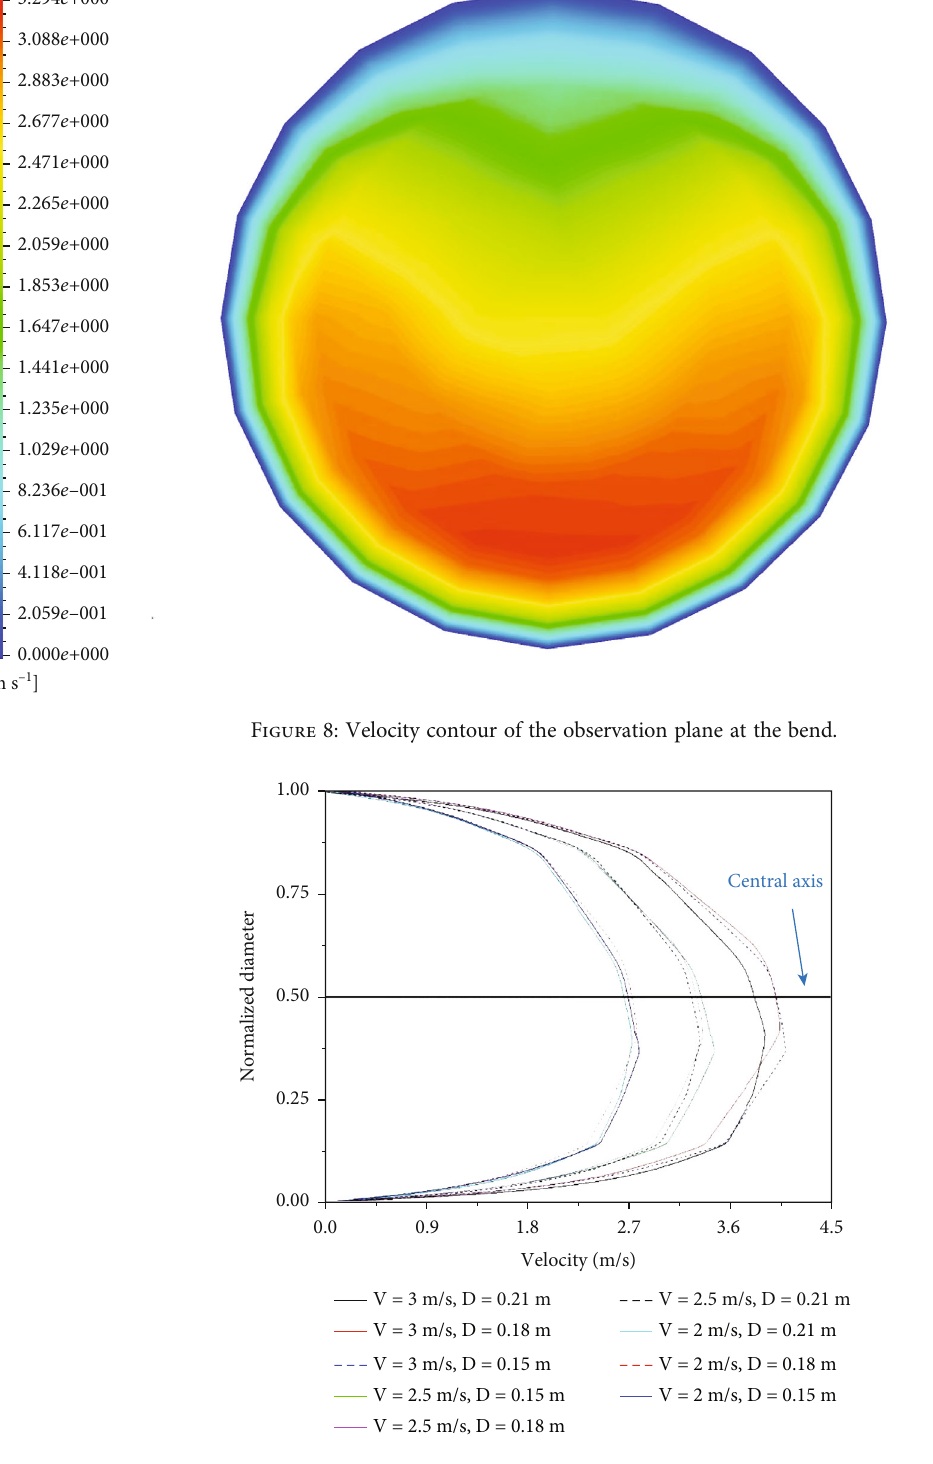
Figure 9: Velocity on the measurement line X = Y